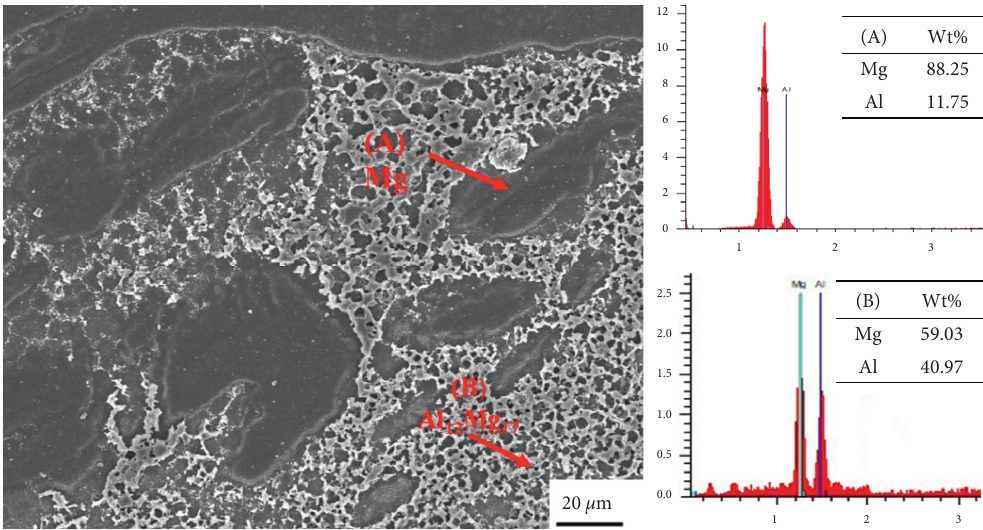
Figure 13: SEM view and the EDS element analysis of the IS.